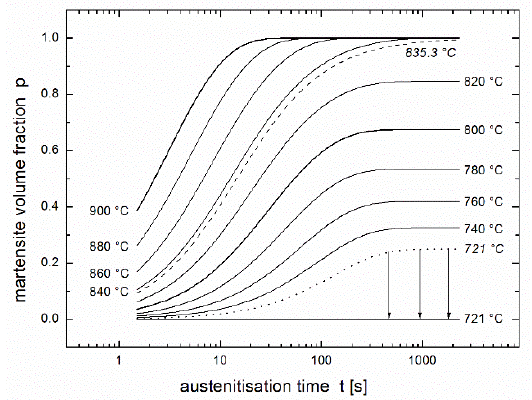
Figure 4. Family of predictive curves for the given temperatures. Prediction is based on the regression using the equation of autoinhibition (3) and the Arrhenius equation (2) or (8), see Figure 2. Result of regression using Equation (11) instead of (8a) or (2) for rate constant k ( T ) is